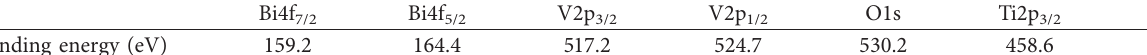
4 /TiO 2 sample determined from XPS data.